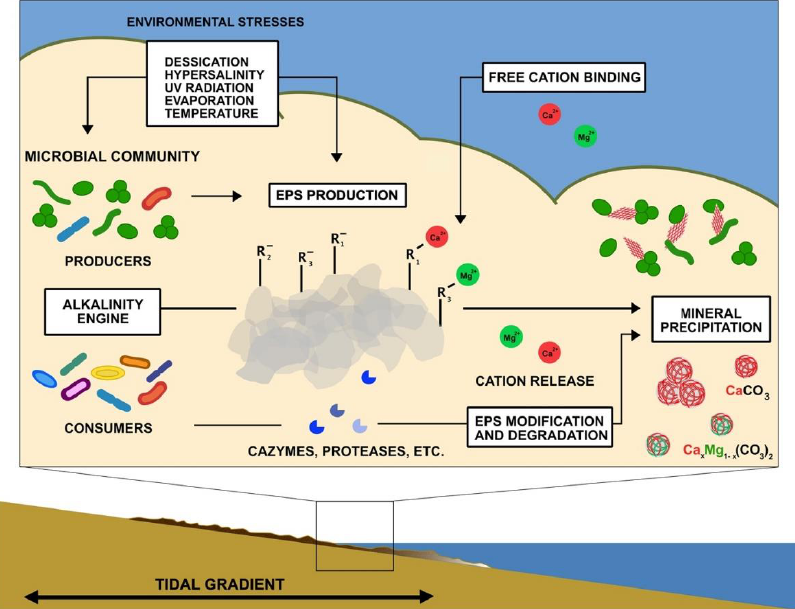
Figure 3. Summary schematic of potential and known factors contributing to mineralization in microbial mats. Environmental stresses enhance EPS production by photosynthetic microbes and other organisms. Negatively charged functional groups trap and bind free cations on the surface of EPS. Microbial metabolic processes that contribute to EPS production and degradation (alkalinity engine) can influence the concentrations of carbonate ions, release cations, and modify organic surfaces or produce organic compounds that influence mineral nucleation and growth.